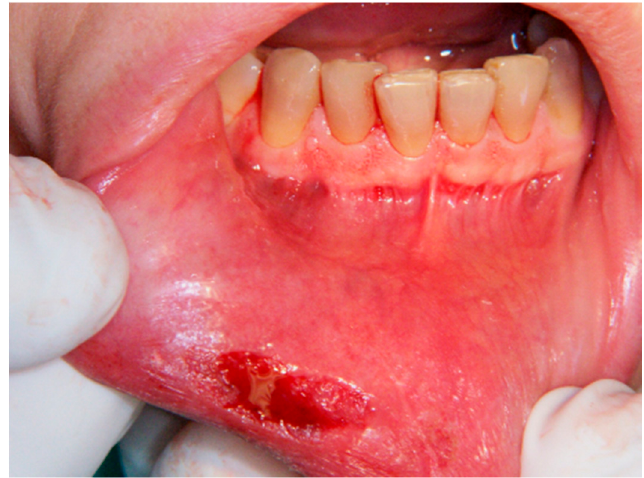
Figure 3. Bleeding which appeared after lesion excision.